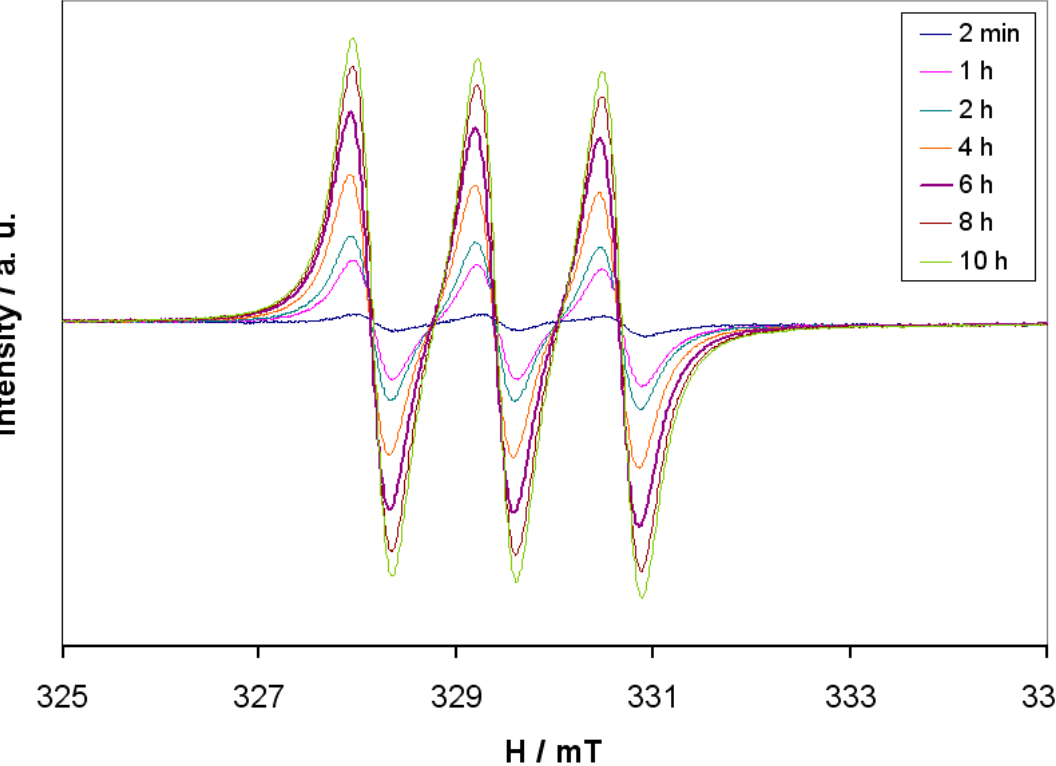
Figure 3. Increase of normalized intensity of EPR signal (measured in arbitrary units) due to Fe(MGD) 2 (NO) as a function of the time in the experiments with PI (0.6 mM in PBS, pH 7.4, 37 °C). All spectra were recorded with the same instrumental parameters.